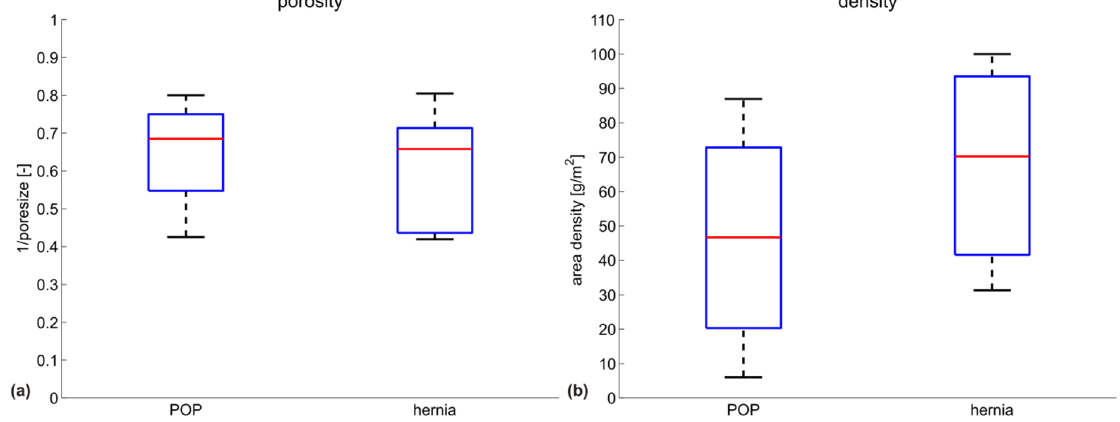
Figure 7. Box plots for ( a ) porosity and ( b ) area density of all meshes. The red line marks the median of the group; the box represents the 25th and 75th percentile; the extended whiskers the most extreme data points. Porosity is shown as the inverse of pore size, i.e. , higher values represent smaller